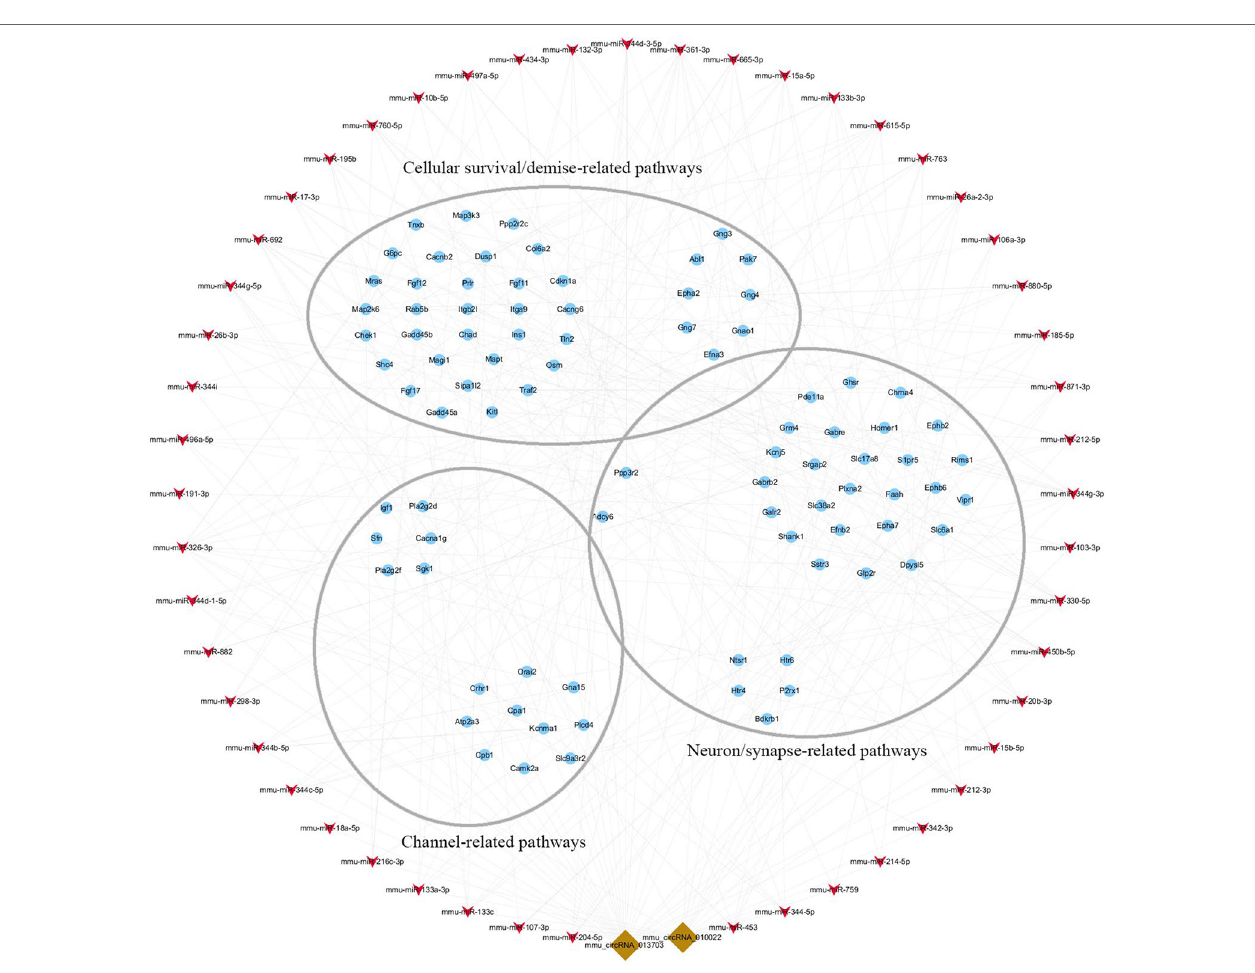
FIGURE 9 | Enrichment analysis of (A) GO term and (B) pathway term for circRNA co-expression genes. The top 10 changed GO/pathway terms were drawn in enrichment bubble diagrams. Bubble scales represent the number of differently expressed genes. The depth of the bubble color represents the p-value.